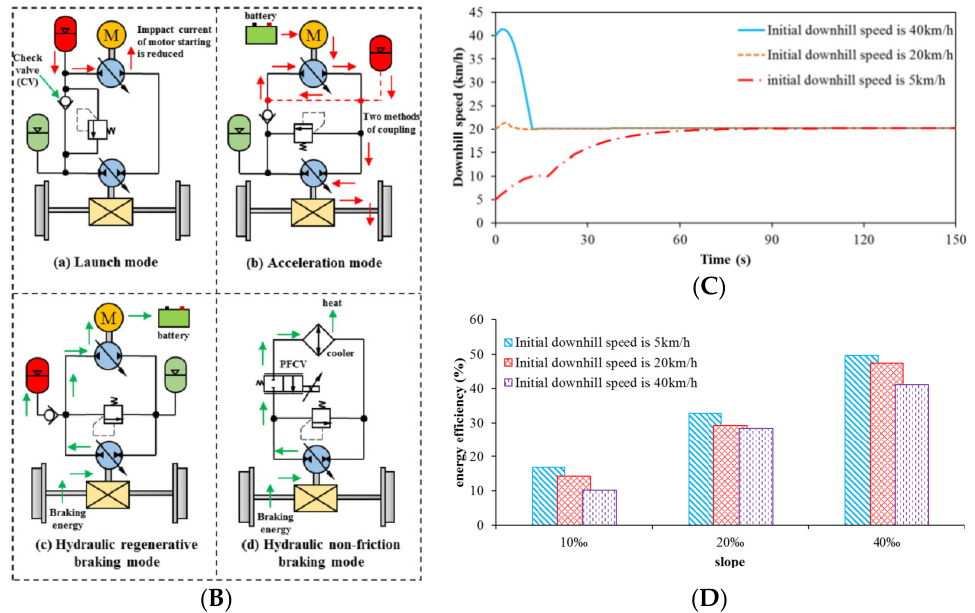
Figure 19. Architecture and characteristics of EH3 [53]: ( A ) EH3 powertrain; ( B ) working modes, ( a ) launch mode, ( b ) acceleration mode, ( c ) hydraulic regenerative braking mode, ( d ) hydraulic non– friction braking mode; ( C ) downhill speed control; ( D ) energy efficiency under different conditions.